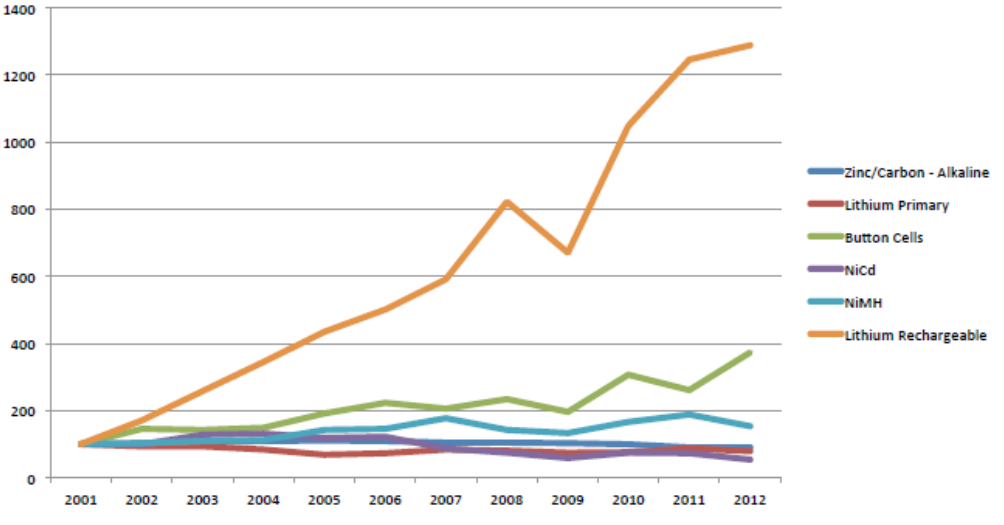
Figure 1. Growth of battery types in Europe (2001 = 100%) [62].